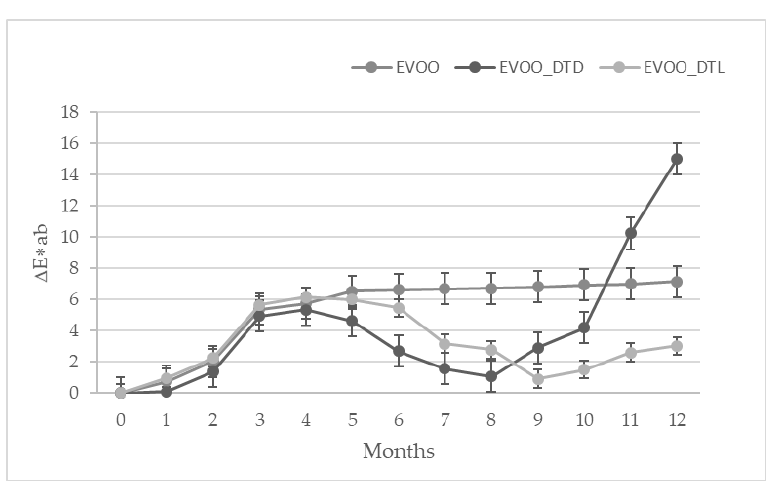
Figure 1. Evolution of ∆ E*ab values during 12 months of storage.